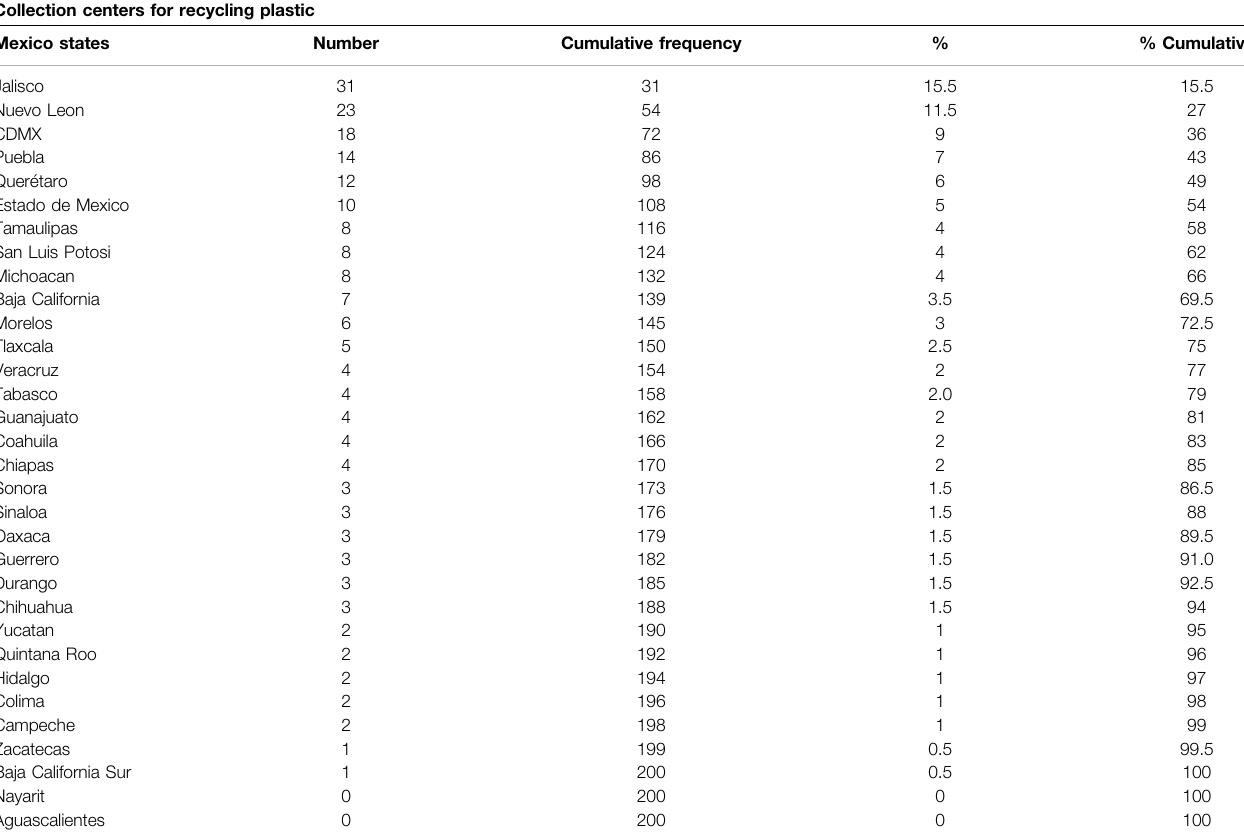
TABLE 3 | The infrastructure of the main states of Mexico where People can recycle plastic and electronics. Collection centers for recycling plastic Mexico